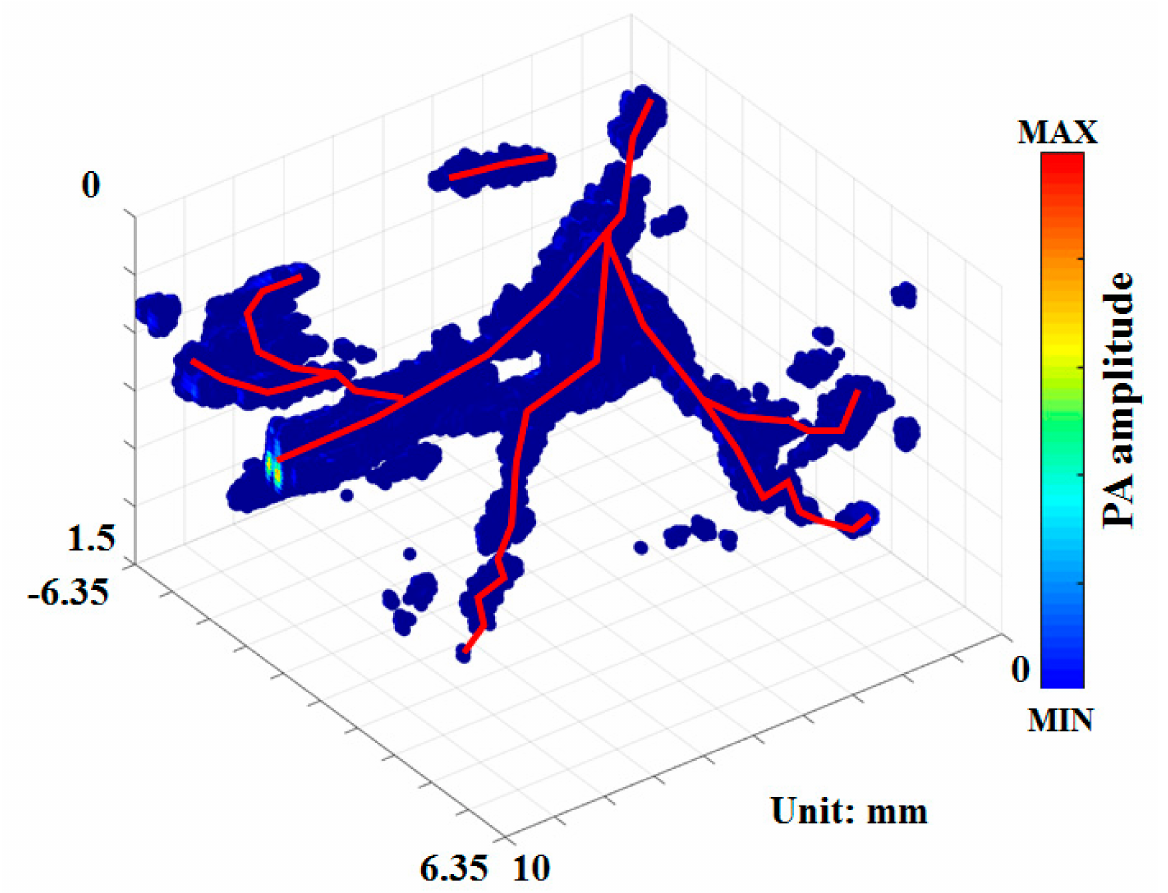
Figure 3. PA images of blood vessels acquired by imaging the skin on the back of a rat. Laser excitation at 750 nm was used to acquire in vivo PA C-scan images. The trends of blood vessels in the skin are indicated by solid red